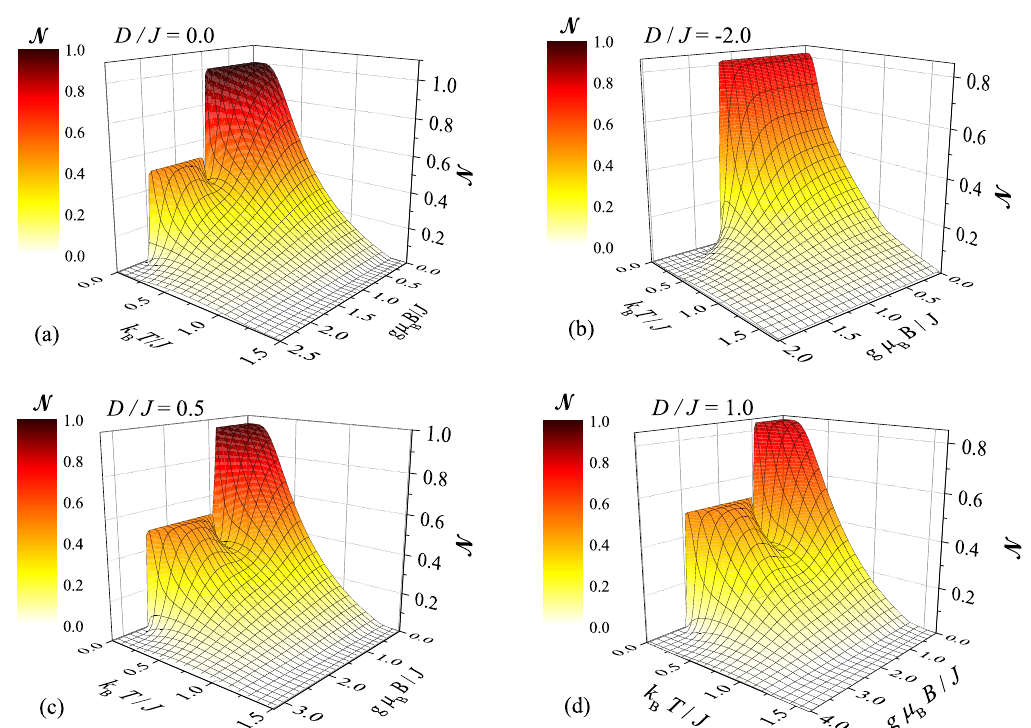
Figure 5. 3D plots of the negativity of the spin-1 Heisenberg dimer with the isotropic exchange interaction ∆ = 1 as a function of temperature and magnetic field for four different values of the uniaxial single-ion anisotropy: ( a ) D / J = 0.0; ( b ) D / J = − 2.0; ( c ) D / J = 0.5; ( d ) D / J =